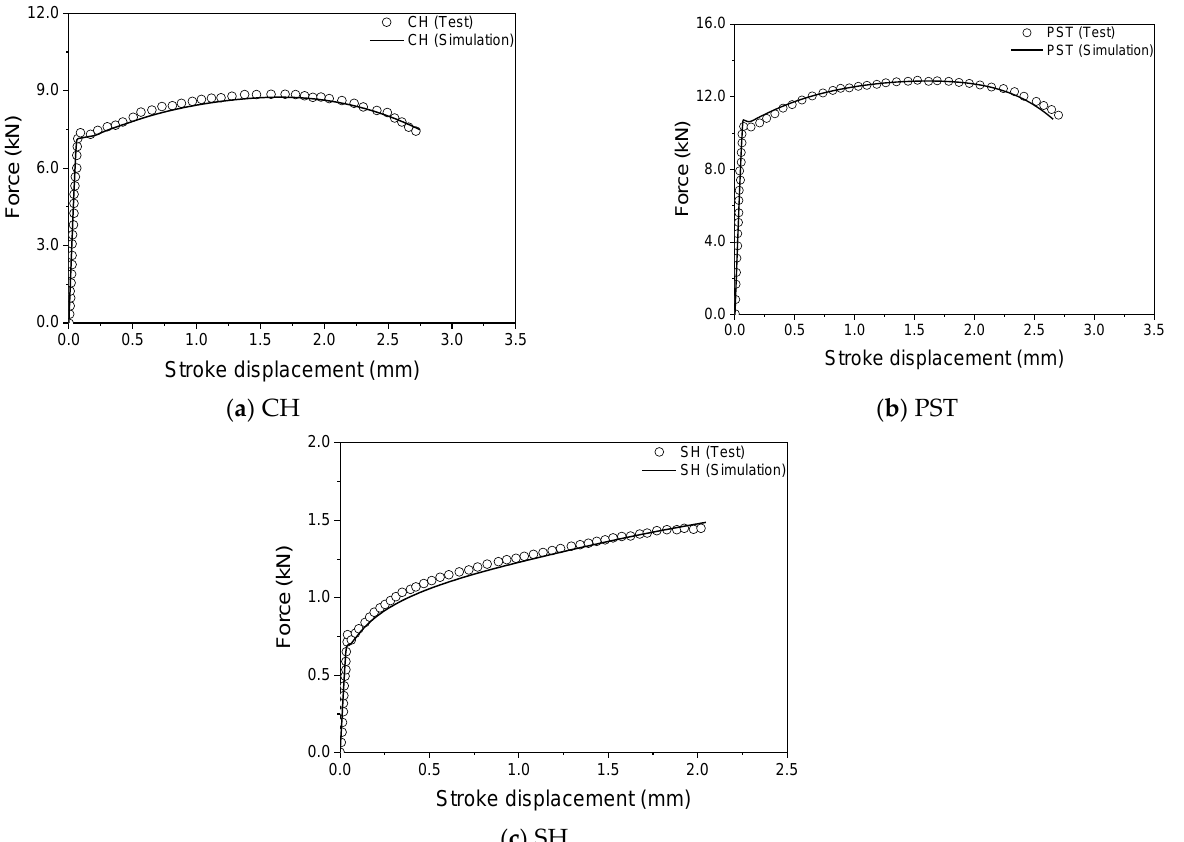
Figure 8. The comparisons of force-displacement between experimental and numerical results.